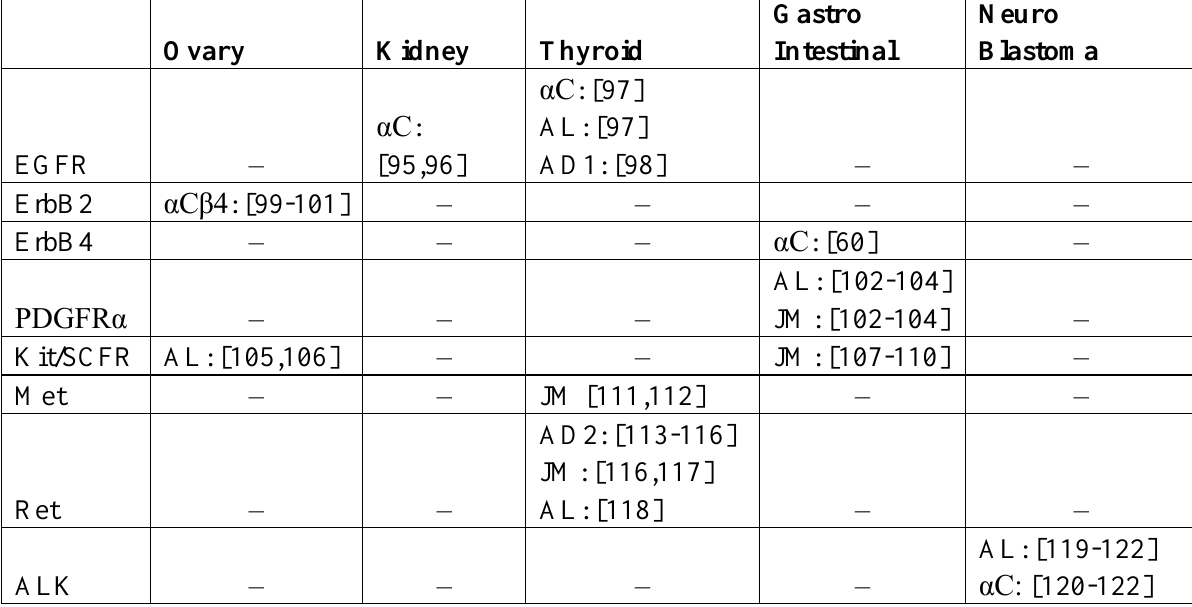
Table 2. Currently known clinically identified activating or biologically significant cytoplasmic domain mutations in RTKs classified by kinase sub-domains associated with the most lethal tumor types. JM: juxtamembrane domain, PL: P-loop, αC: αC-helix, αC-β4: